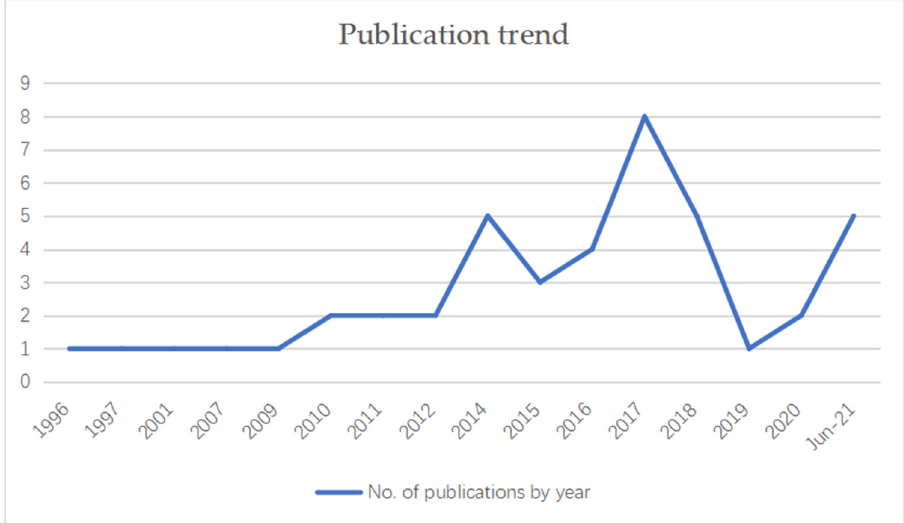
Figure 3. Numbers of selected articles published by year.